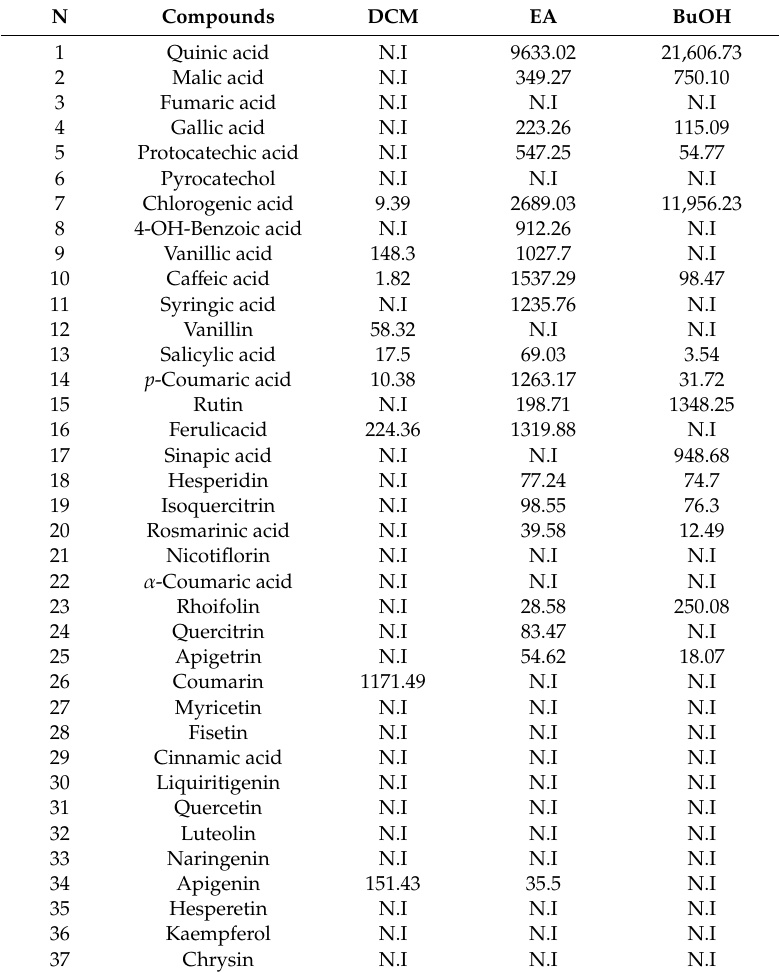
Table 3. Quantitative determination of 37 phenolic compounds in the extracts of Hypochaeris laevigata var. hipponensis ( µ g / g extract) by LC-MS / MS.